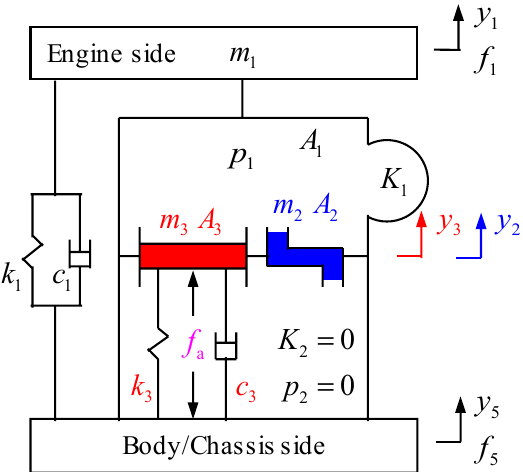
Figure 2. Unified lumped parameter mechanical model for AHM-IT-DMs and PHM-IT-DMs.